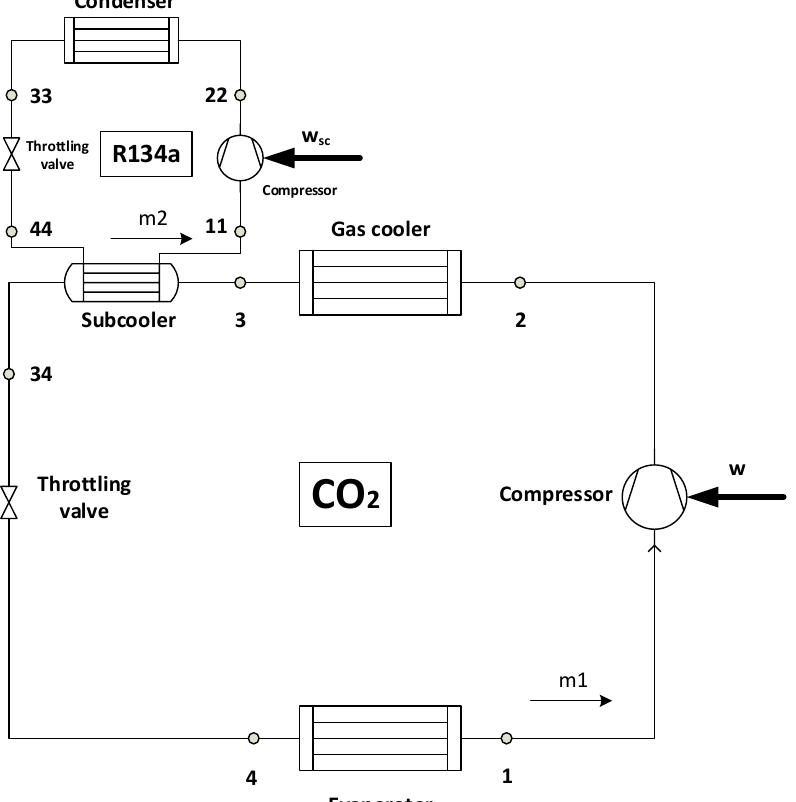
Figure 2. System with dedicated mechanical subcooling (M-SC).